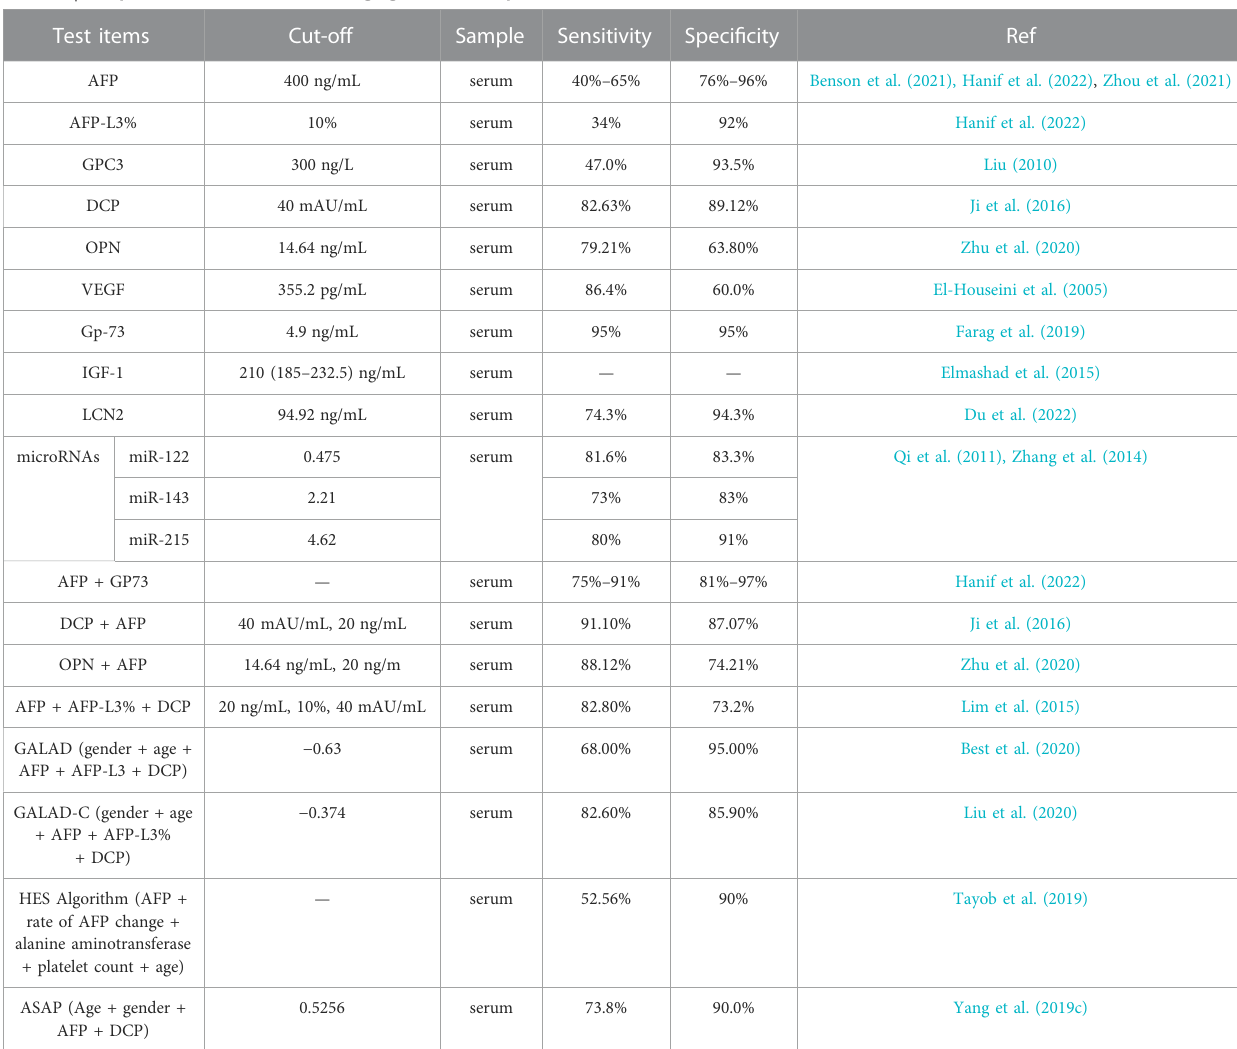
TABLE 1 | Comparison of biomarkers and imaging studies in hepatocellular carcinoma. Test items